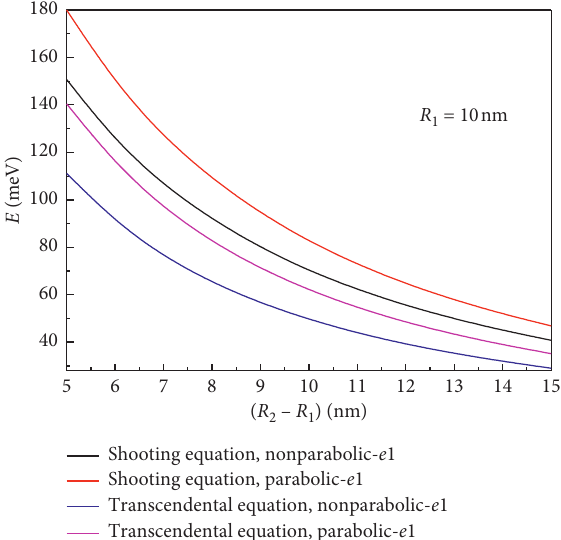
Figure 13: The dependence of the energy of a light hole on the layer thickness of a cylindrical quantum nanorod with a finite potential.